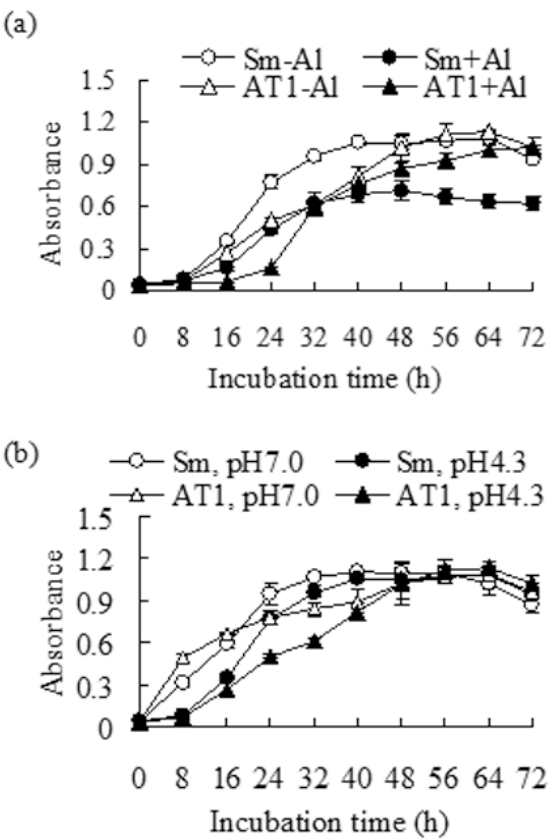
Figure 1. Growth curves of rhizobia strains AT1 and Sm1021. An identical volume of AT1 or Sm1021 was inoculated to the liquid medium (pH 4.3) containing 0.5 mM CaCl 2 and 1 mM AlCl 3 ( a ), or the liquid medium adjusting to pH 7.0 or pH 4.3 ( b ). The rhizobia were incubated at 28 ◦ C with shaking. The data presented are means ± SE ( n = 5).